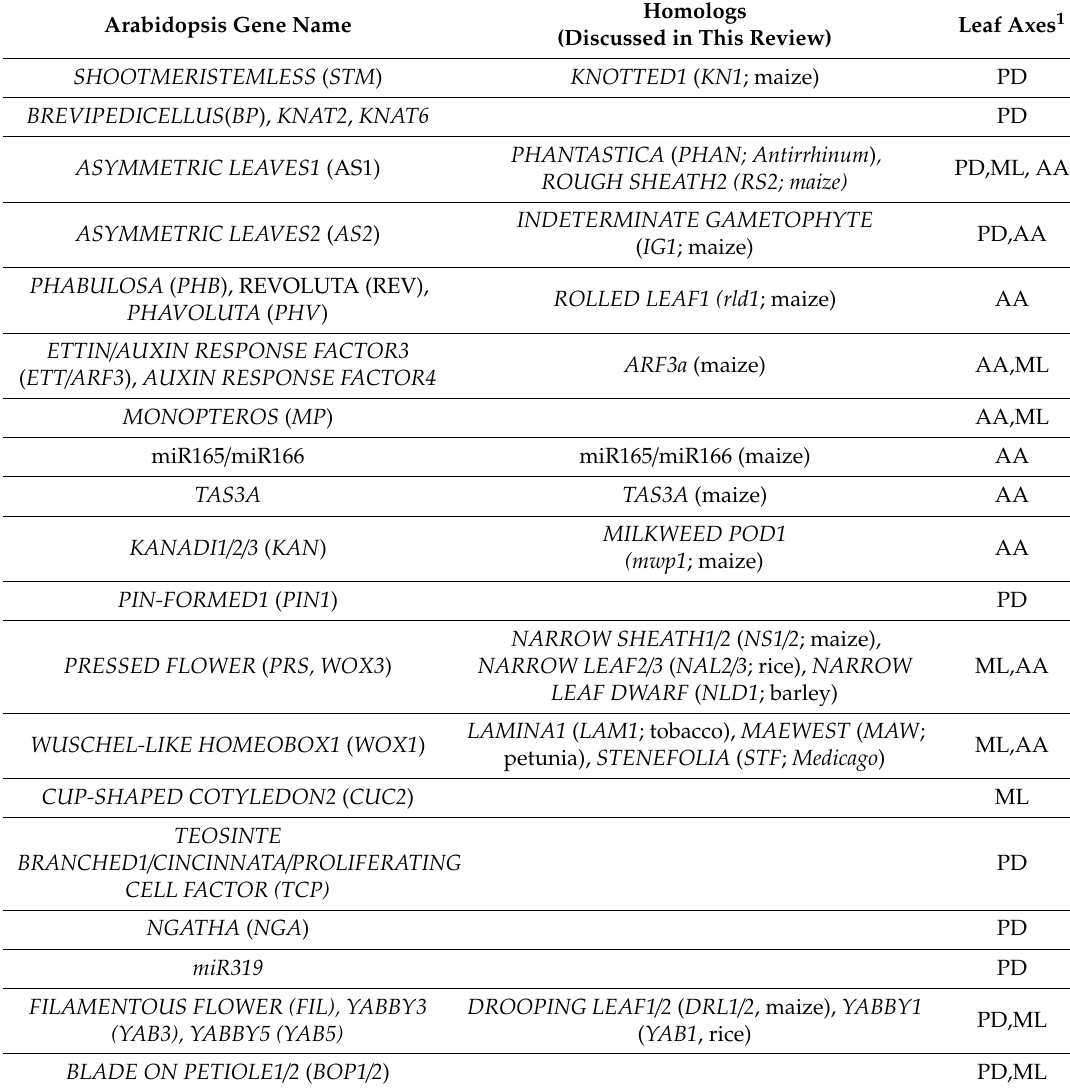
Table 1. Key genes mentioned in the text, their relevant homologs in other species, and the leaf axes they